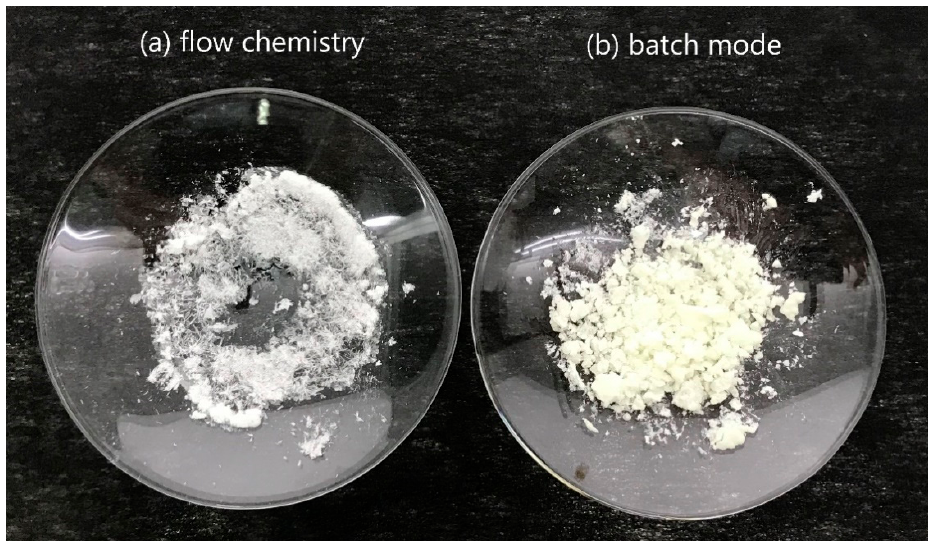
Figure 3. TNT produced from ( a ) flow chemistry and ( b ) batch mode. The flow chemistry sample is white, whereas the batch mode sample has a yellow hue caused by impurities.